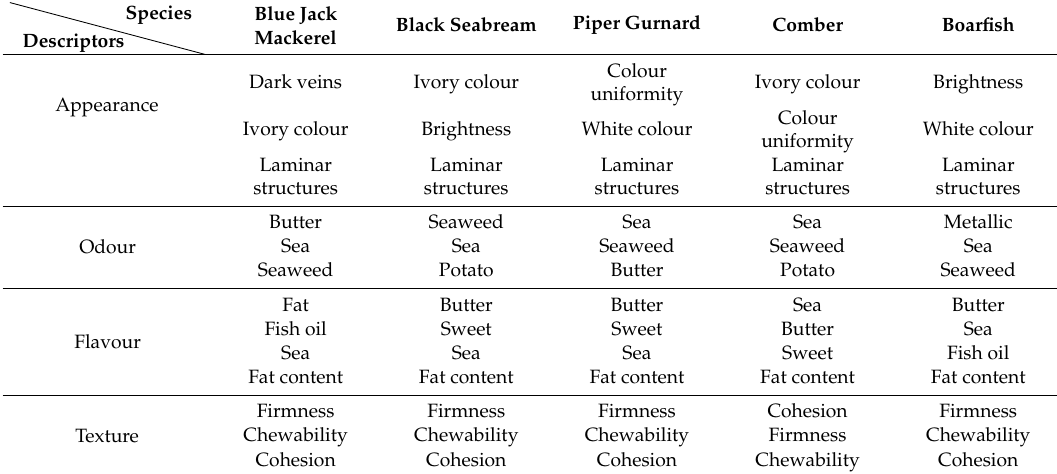
Table 1. Descriptors checklist used for sensory analysis throughout the year for each species